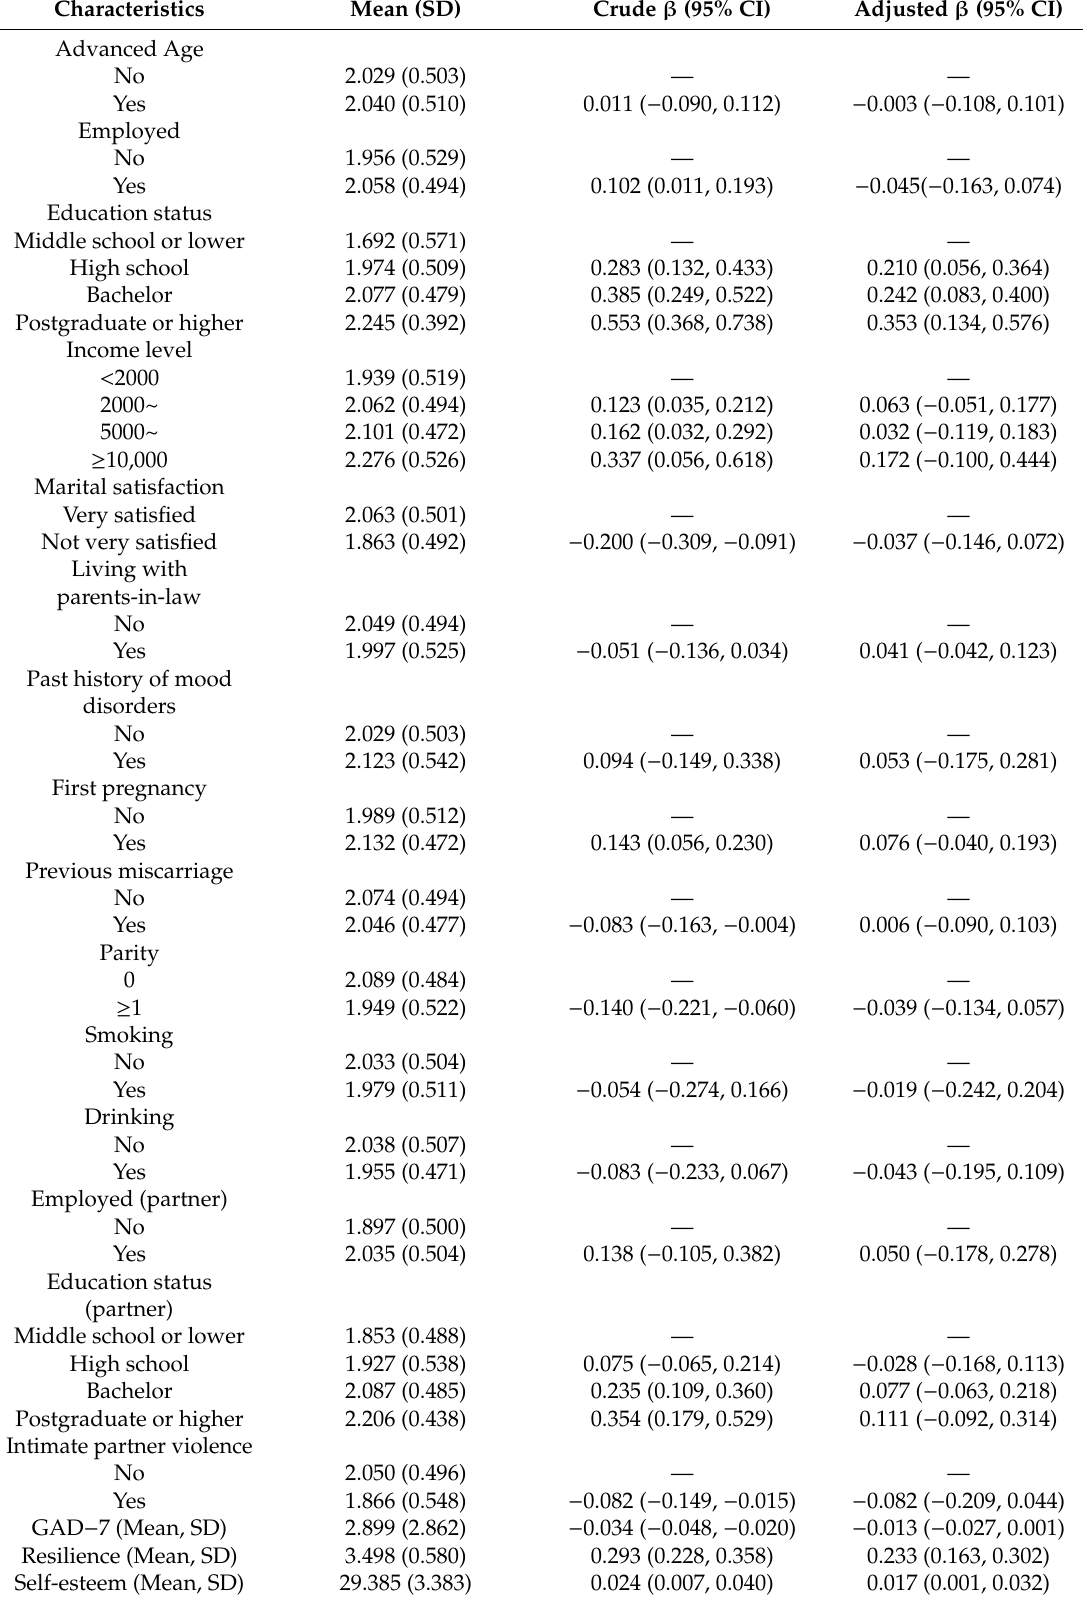
Table 3. Influencing factors of positive